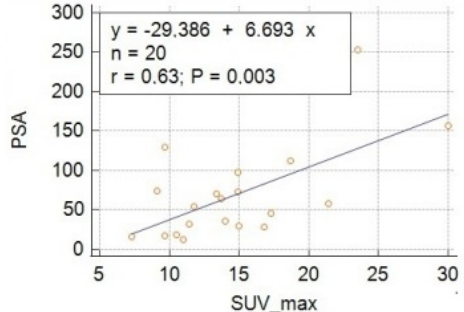
Figure 1. Regression analysis showing the correlation between baseline levels of PSA and maximum standardized uptake value (SUVmax).